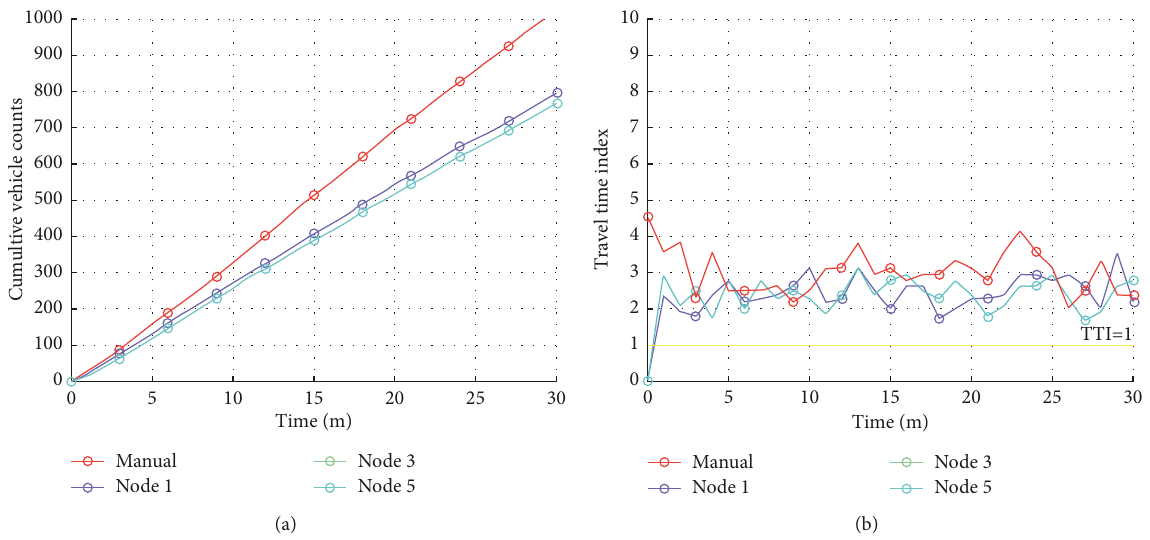
Figure 11: Simulation results were two sensors nodes (1 and 5) were used to monitor congested traffic flow on eastbound lanes: (a) cumulative vehicular count; (b) Travel Time Index (TTI).